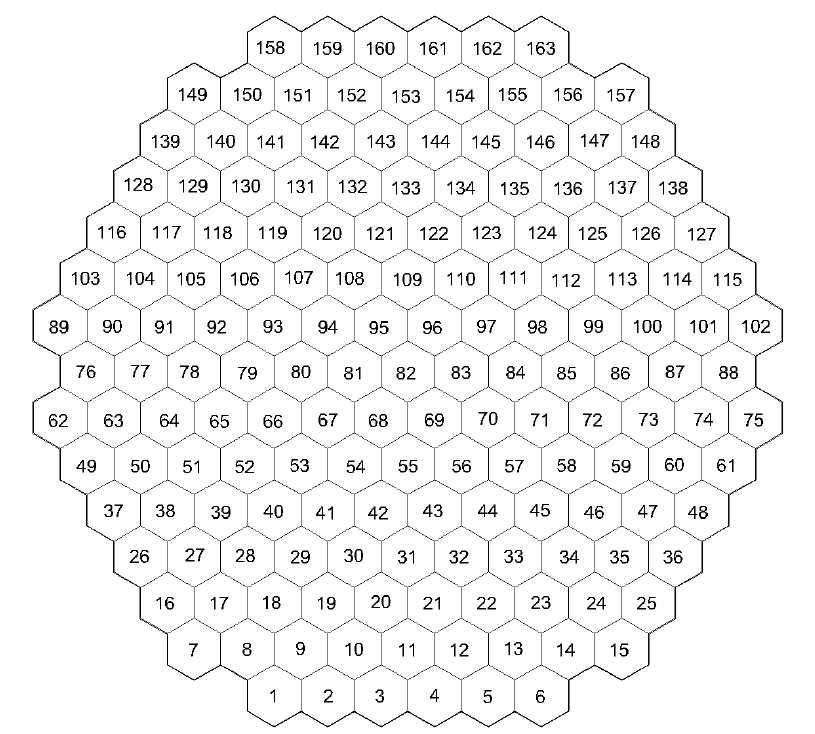
Figure 1. Core subchannel model with subchannel (fuel assemblies) numbering.